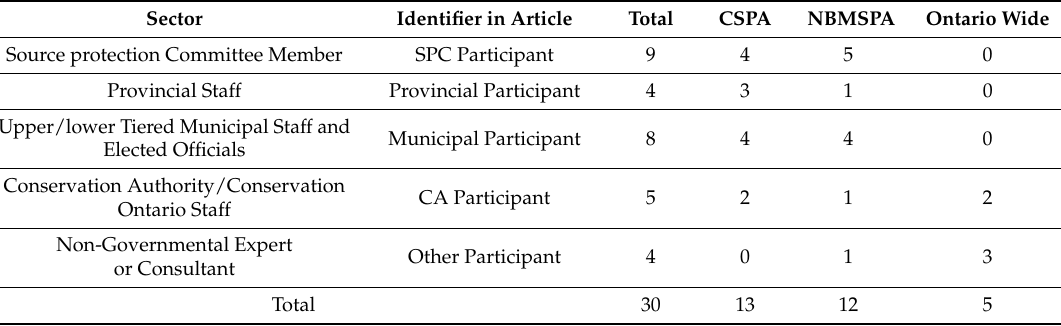
Table 1. Key Informant Interviews Analyzed ( n =